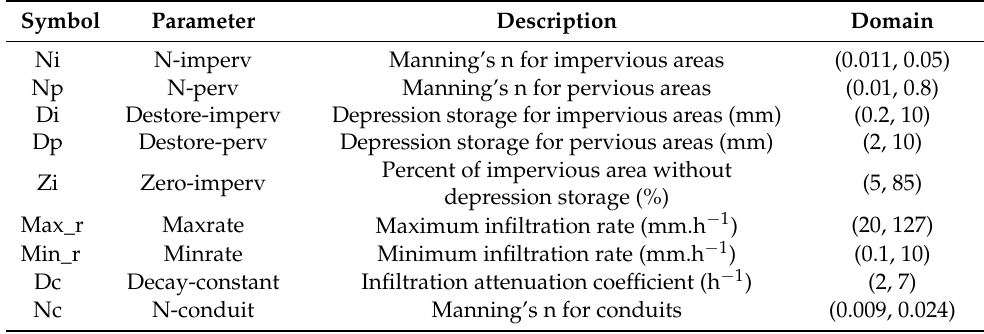
Table 1. SWMM model’s hydrological and hydraulic parameters.